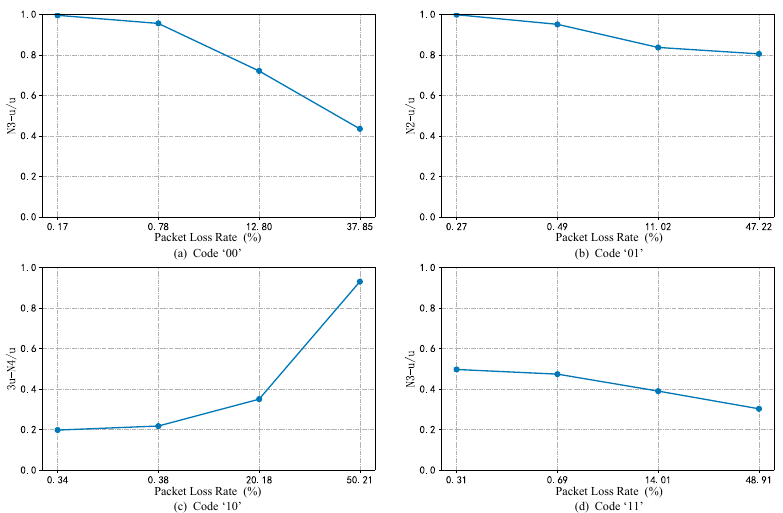
Figure 12. The Crps in the different packet loss rate in Figure 7c.